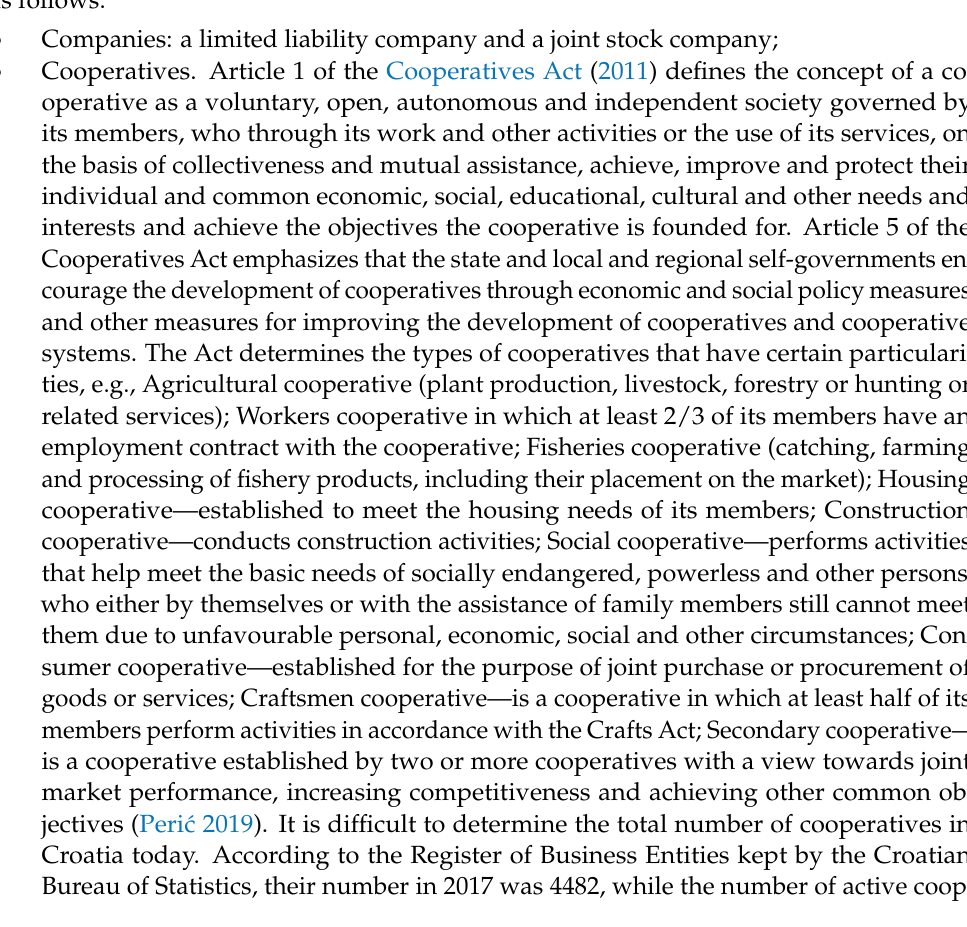
Figure 5. Tool for qualitative risk assessment: probability and impact matrix. Source: Authors., adapted from Project Management Institute (2017b, p. 408).